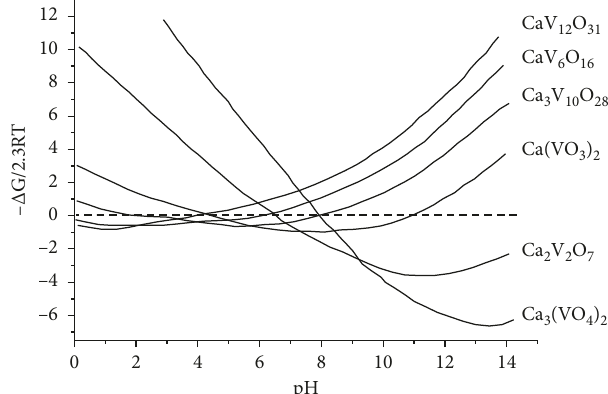
Figure 2: Δ G S versus pH for different CaO–V 2 O 5 –H 2 O systems at C V � C Ca � 1mol · L − 1